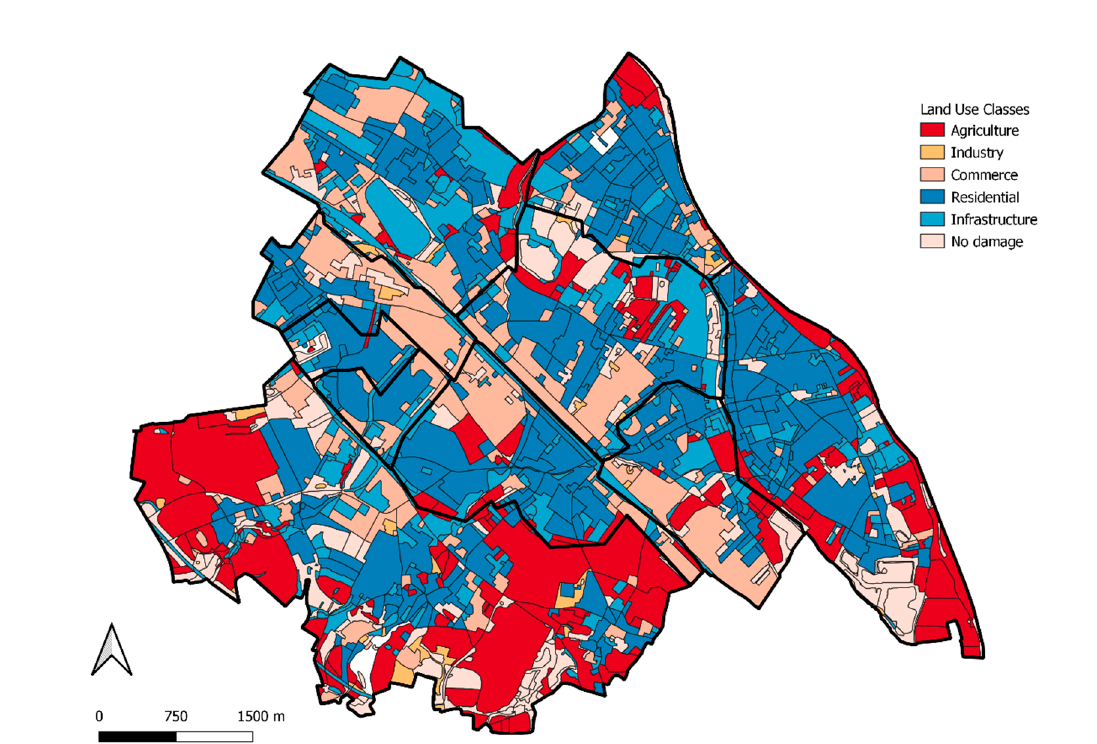
Figure A2. Reclassified land uses.